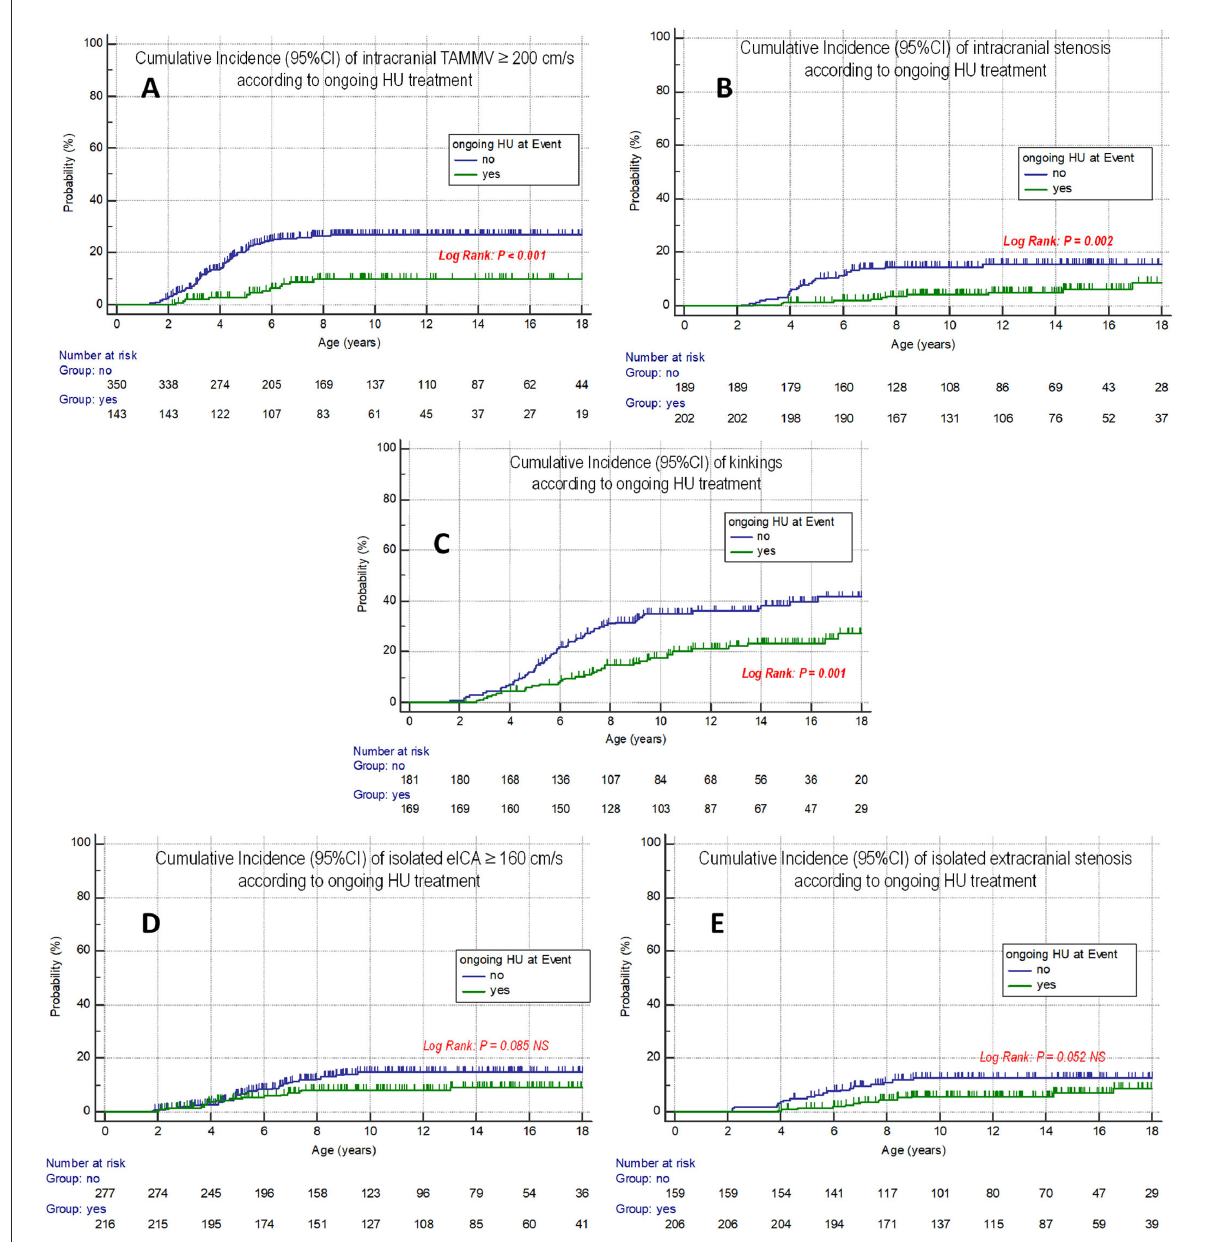
FIGURE4 Cumulative incidence of intra- and extracranial arteriopathies in SCD children according to ongoing hydroxyurea treatment at each event. (A) Intracranial TAMV ≥ 200 cm/s. (B) Intracranial stenosis. (C) eICA kinking. (D) eICA-TAMV ≥ 160 cm/s. (E) eICA stenosis.